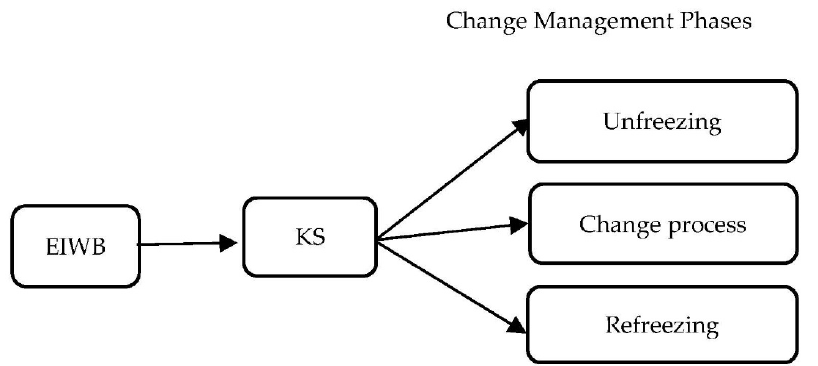
Figure 1. Conceptual model of the